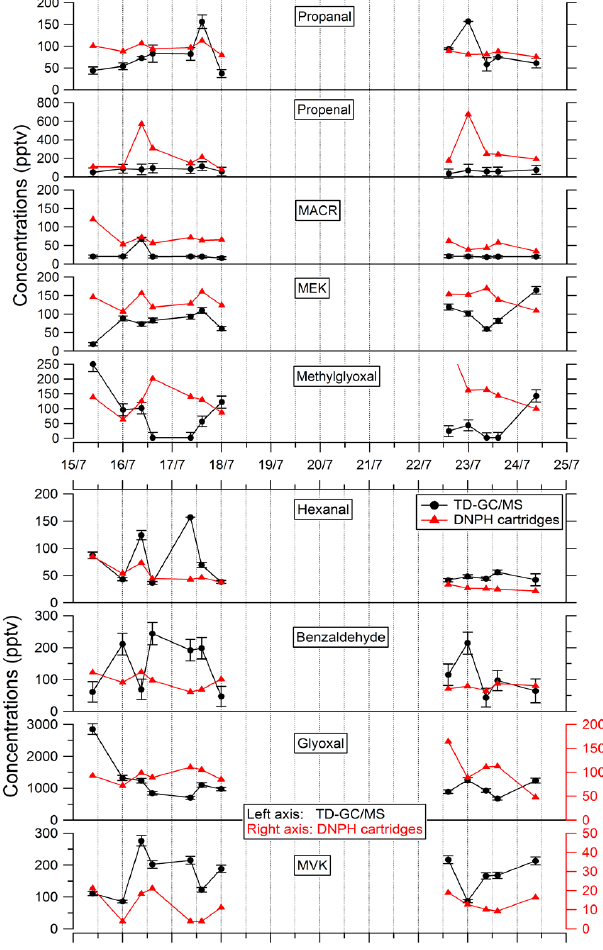
Figure 6. Comparison of ATD–GC–MS data with DNPH cartridge analysis for nine OVOCs. Error bars correspond to the 1 σ uncer- tainties in TD–GC–MS measurements.